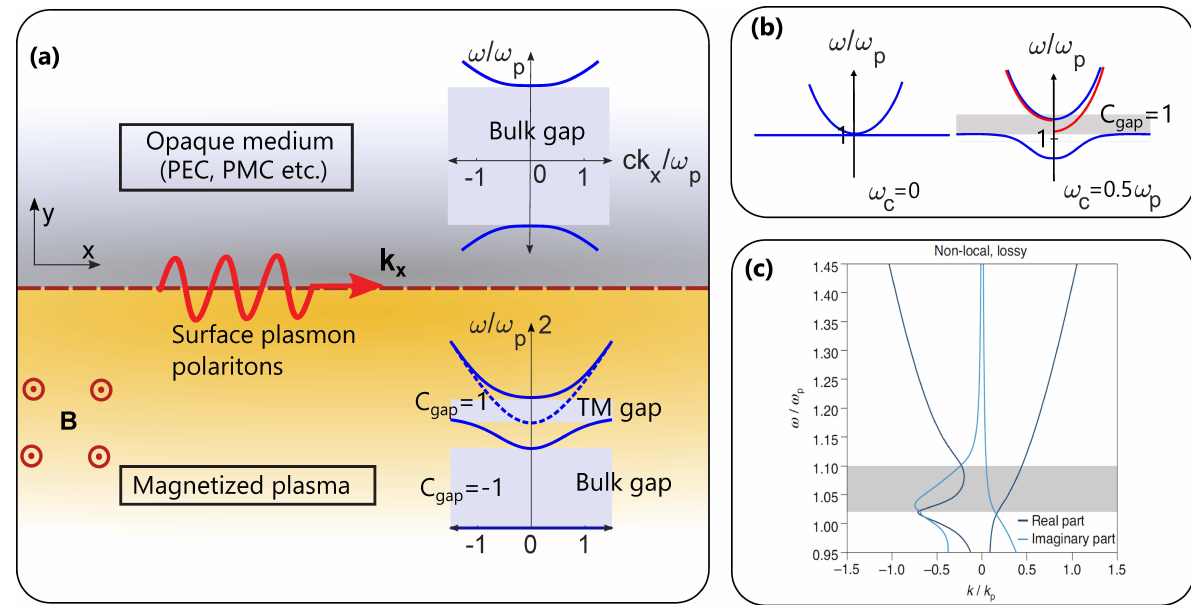
Figure 7. Topologically protected surface plasmon-polariton modes on an interface between a semi-infinite magnetized plasmonic medium and an opaque medium, in the plane orthogonal to the bias. ( a ) Geometry of the interface in the plane orthogonal to the applied magnetic field (geometry, bias, and SPP fields are invariant in the out-of-plane (z) direction). Inset: Typical bulk-mode dispersion diagrams. The gap Chern numbers for the magnetized plasma are calculated by summing the Chern numbers of all the bands below the gap (see Figure 3). ( b ) Bulk-mode and surface-mode dispersion diagrams for a plasma-metal interface for a plasmonic material with zero magnetic bias ( left ) and non-zero bias ( right ). The bulk modes are indicated in blue and the single topological unidirectional surface mode that spans the bulk-mode bandgap is indicated in red. Note that the plasma bulk-mode dispersion is only gapped for TM-polarized waves (solid blue lines) as shown in the dispersion diagram in the bottom inset of panel ( a ). ( c ) Topological SPP dispersion diagram calculated using a non-local, lossy hydrodynamic model. Although nonlocality does not affect the topological mode, large losses result in an overdamped counterpropagating mode. ( c ) reproduced with permission from [57].